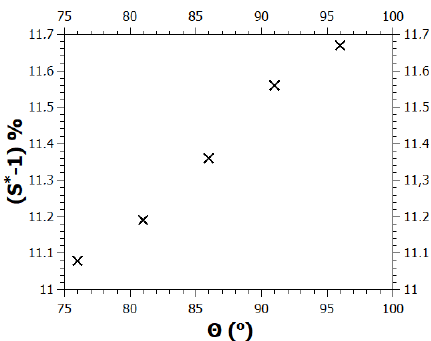
Figure B3. Critical supersaturations in water nucleation as a func- tion of contact angle. The A -parameter values used in the calcu- lations are as shown in Fig. B1. The nucleation temperature is + 25 ◦ C, and the dry particle diameter is